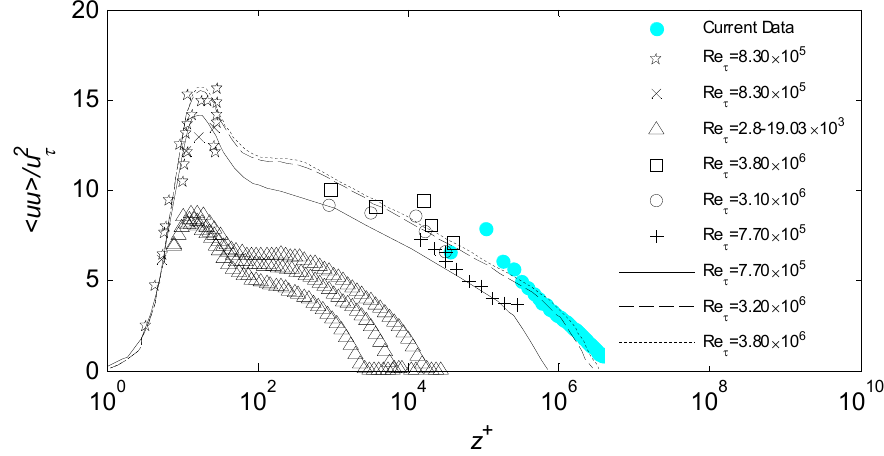
Figure 4. Comparison of uu / u 2 τ in inner-scaled height simulation results with a similarity formulation from Marusic and Kunkel [41]: The solid colored circles are current simulation data at Re τ = 3.553 × 10 6 , the open circles and squares are for the result of Kunkel and Marusic [38] at Re τ ≈ 3.1 × 10 6 and 3.8 × 10 6 , respectively, the black pluses exhibit the result of Hutchins et al. [36] at Re τ = 7.7 × 10 5 , the times and open stars represent Metzger et al. [39] at Re τ ≈ 8.3 × 10 5 , the open upper triangles show